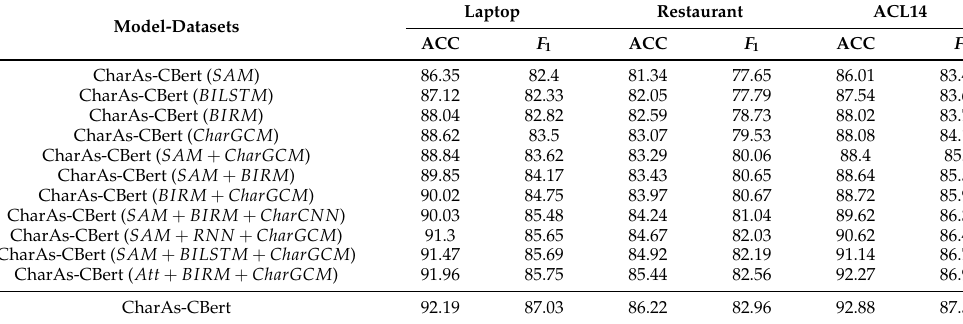
Table 3. Experimental results of different components. SemEval2014 including Laptop and Restaurant. SAM + BIRM + CharCNN indicates that the framework uses the three components SAM, BIRM, and CharCNN at the same time, and uses CharCNN to replace the CharGCM component we proposed; SAM indicates that the SAM component is used; BIRM indicates that the BIRM component is used; CharGCM means using CharGCM components; SAM + RNN + CharGCM means using RNN to replace our proposed BIRM components; Att + BIRM + CharGCM means using Att to replace our designed SAM components. SAM + BILSTM + CharGCM indicates using a bidirectional long-short memory network (BILSTM) to replace the